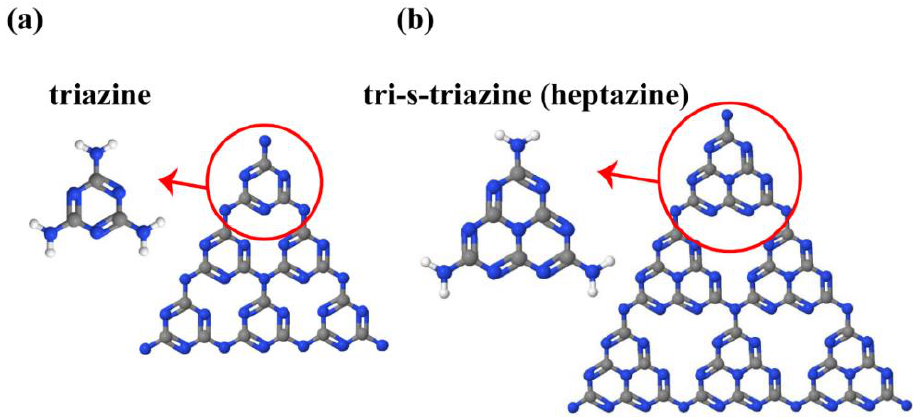
Figure 2. ( a ) Triazine and ( b ) tri-s-triazine (heptazine) structures of g-C 3 N 4 (gray, blue, and white balls are carbon, nitrogen, and hydrogen, respectively).